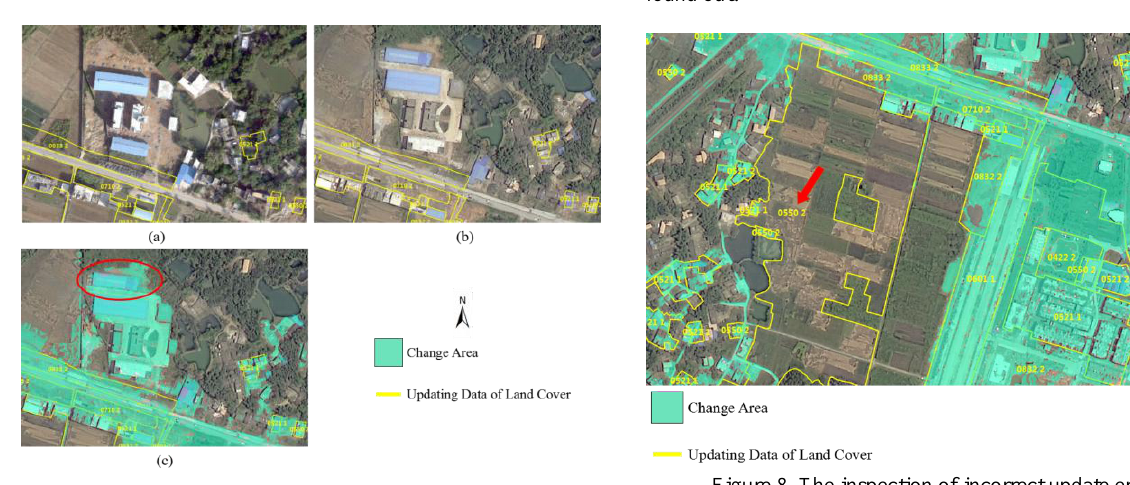
Figure 6. Missing update building inspection assisted by change detection results. (a) The previous image with updating data of land cover. (b) The new image with updating data of land cover.